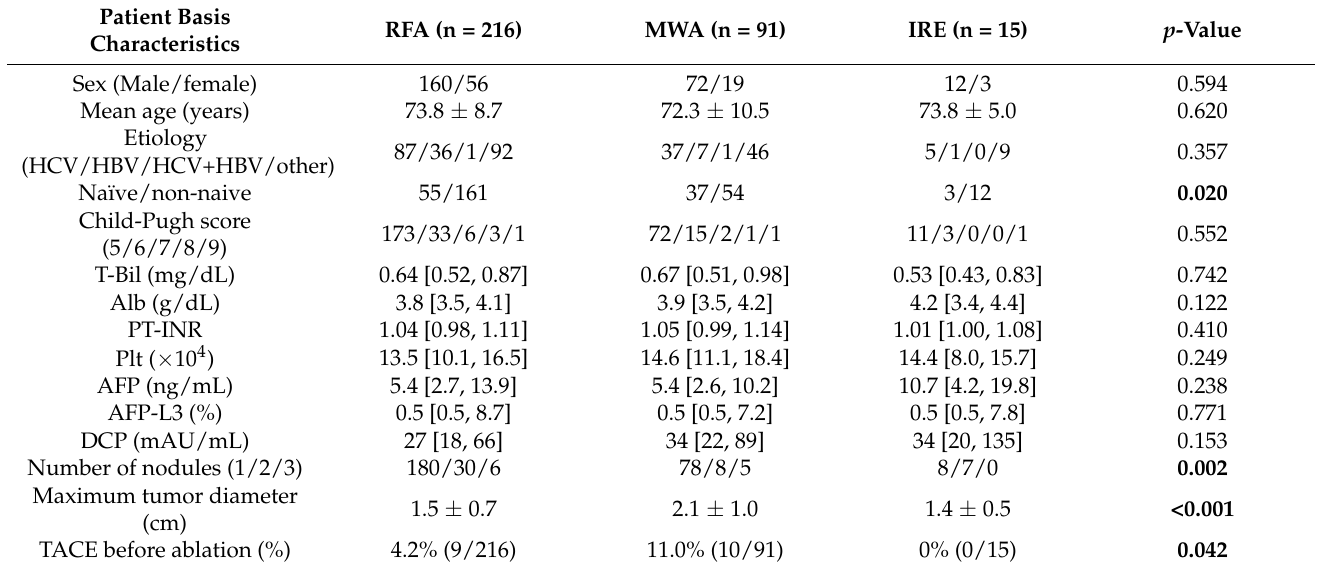
Table 1. Patient characteristics according to three different ablation therapies.